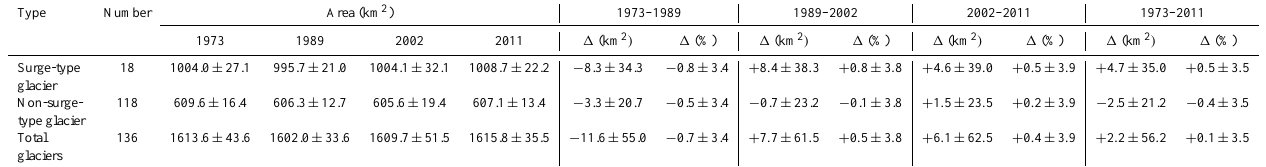
Table 3. Changes in glacier area in the study area between 1973, 1989, 2002 and 2011 based on Hexagon and Landsat images. Type Number Area(km 2